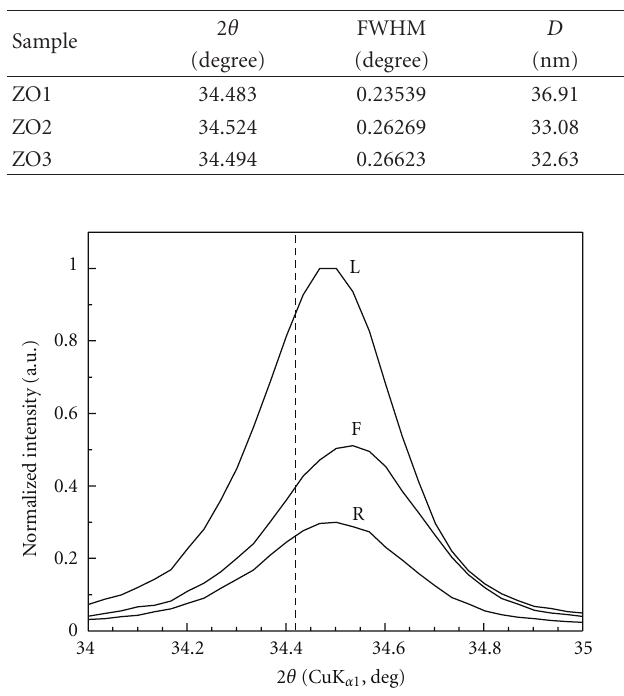
Figure 5: Di ff raction angle shift of (002) peak for the ZnO thin films. Peak intensities are normalized with respect to that of ZnO film on the linear moved substrate (Label L, F, and R show the deposited films on the linear moved substrate, on the fixed substrate, and on the rotated substrate, resp.). Dashed line indicates reference value (34.42 ◦ ).